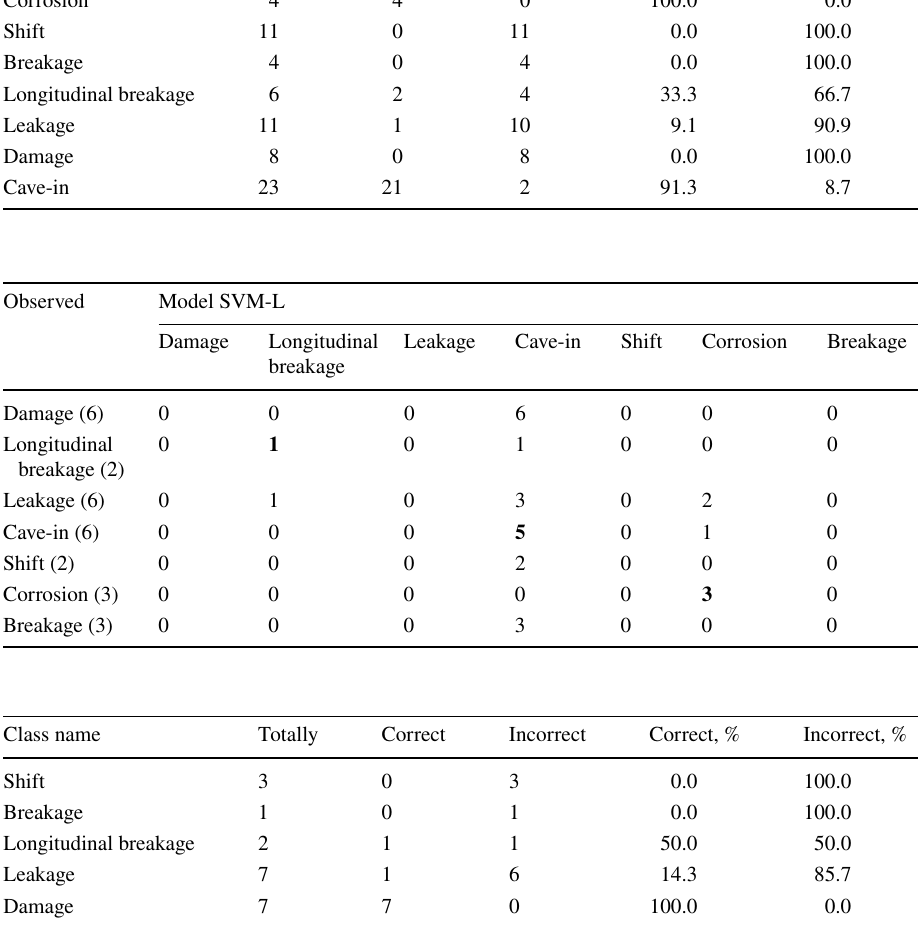
sewers’ damages—model SVM- L, training set